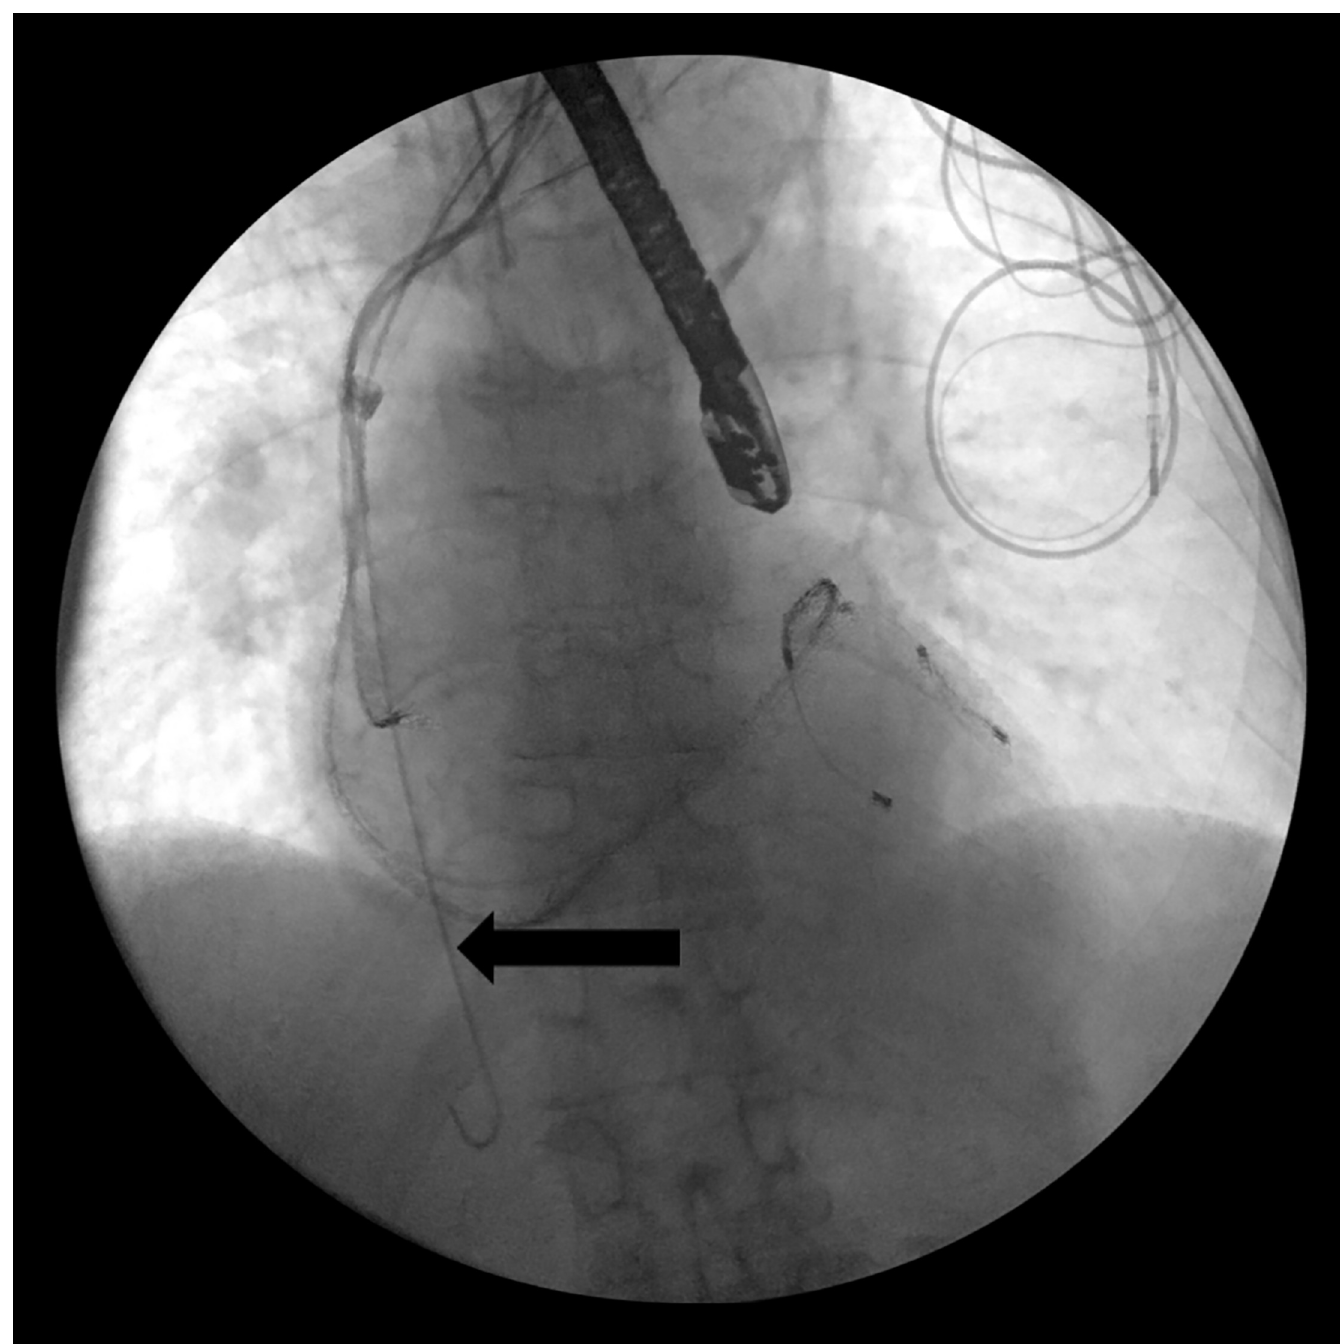
Fig 5. Insertion of the guide wire (marked by the arrow) through the laser sheath for the implantation of a new lead over the venous stenosis.